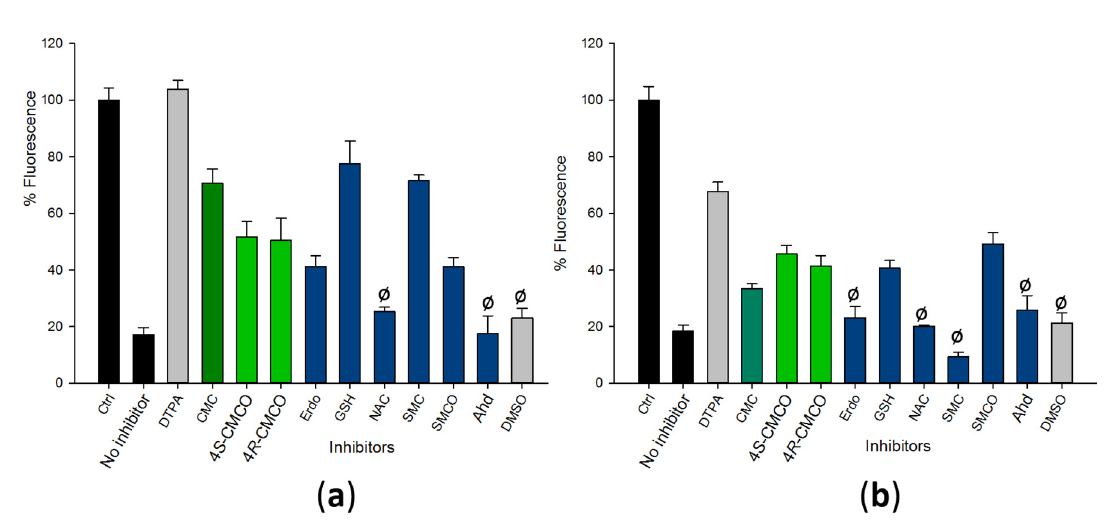
Figure 4. CMC and CMCO protect dsDNA degradation in presence of ( a ) 50 μ M copper/2 mM